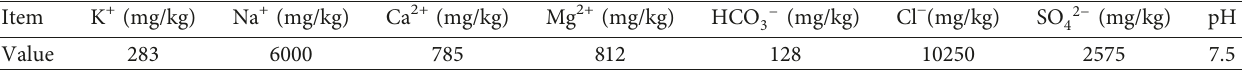
Table 4: Component analysis of soluble salt in saline soil.